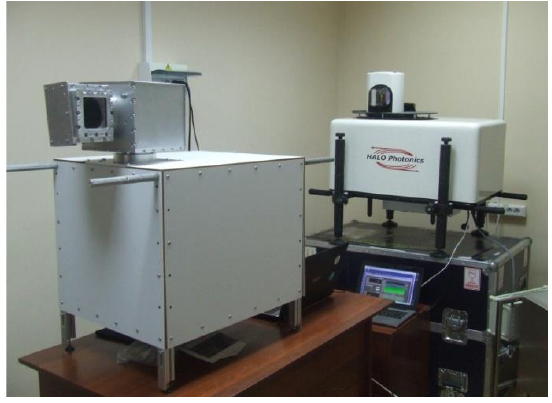
Fig. 4. Lidars: IAO -lidar (left) and "Stream Line" (right) during joint experiment